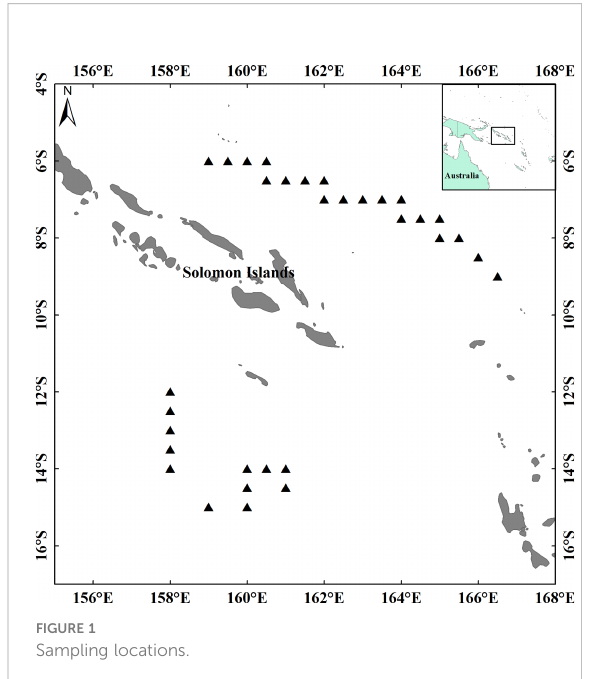
FIGURE 1 Sampling